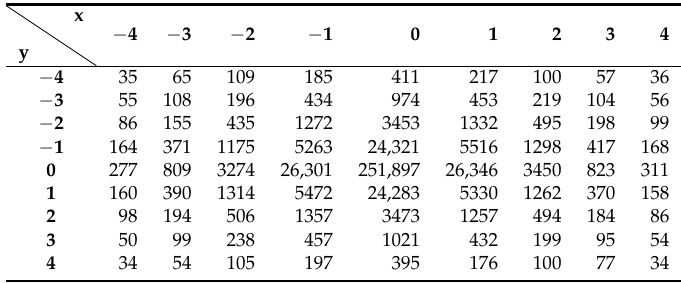
Table 1. The number of different DCT coefficient pairs in the video